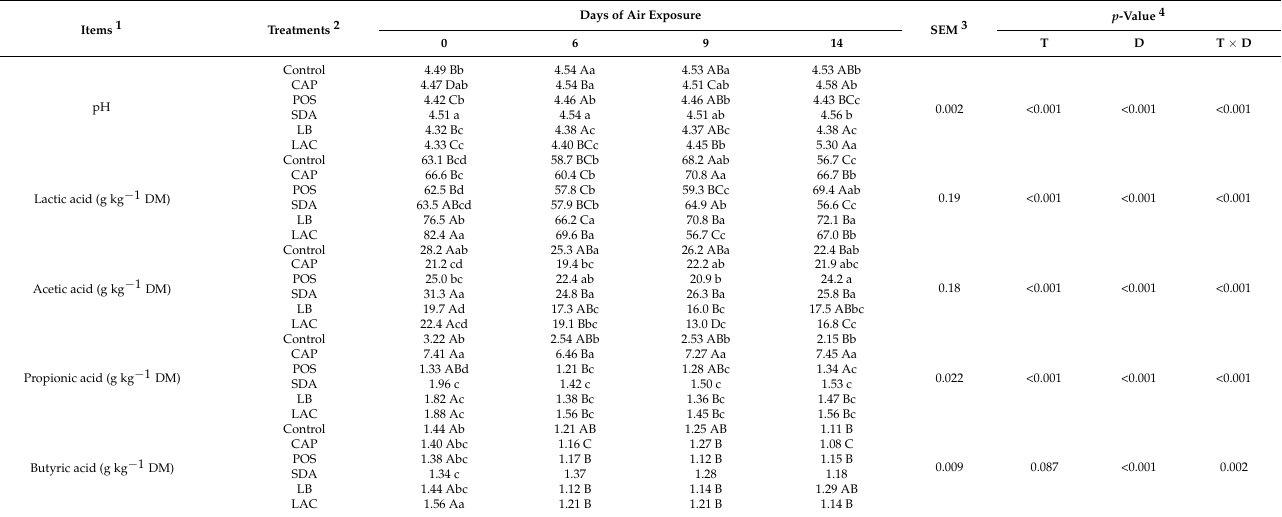
Table 4. Changes in the pH and fermentation products of total mixed ration silage after exposure to